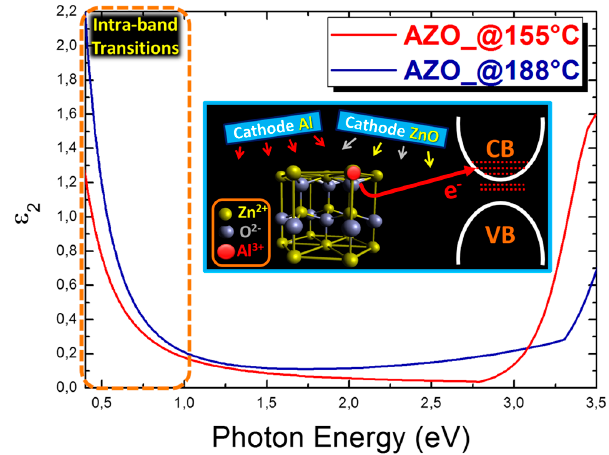
Figure 9. Spectroscopic ellipsometry (SE) measurements giving the dielectric constants ε 2 as a function of the photon energy. Note the absorption in the Infra ‐ Red (IR) region enhanced in the AZO layer deposited at 188 °C, which represents a marker for intra ‐ band transitions as a consequence of the Fermi level entering the conduction band (CB) (inset).